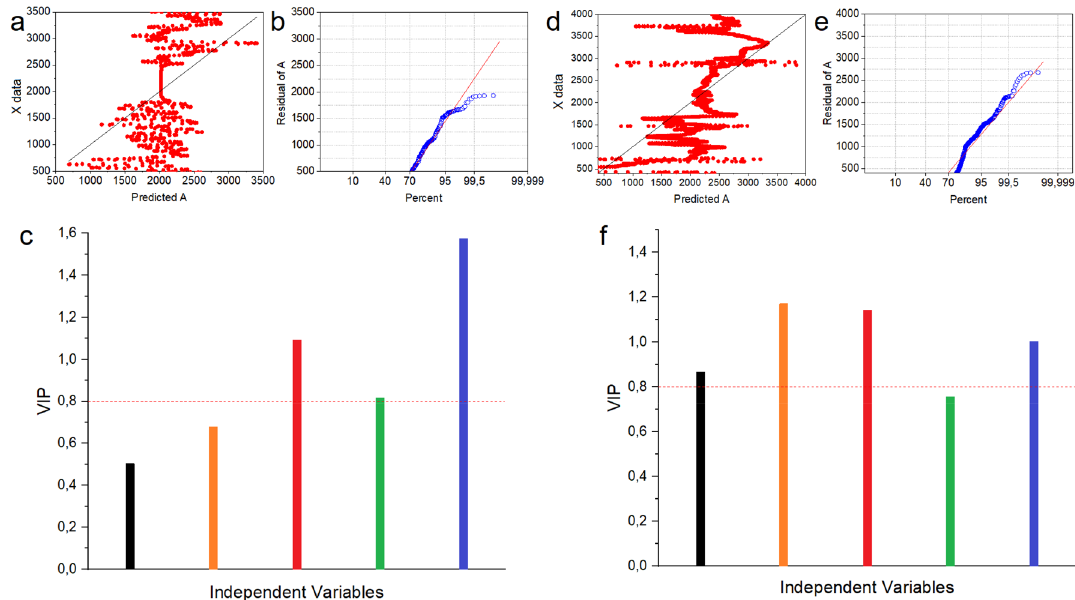
Figure 5. Plots of predicted for Raman ( a ) and FTIR ( d ) region, which could be used to separate endometrial tissues with different carcinogenesis stages. Normal Probability Plot of residual collected from predicted plots for Raman ( b ) and FTIR ( e ) spectra. VIP values plot for the all analyzed Raman ( c ) and FTIR ( f ) range with 0.8 VIP thresholds, where colors stands for the following samples: control (black); atrophic endometrium (orange); complex atypical hyperplasia (red); endometrial polyp (green); endometrioid adenocarcinoma (blue).